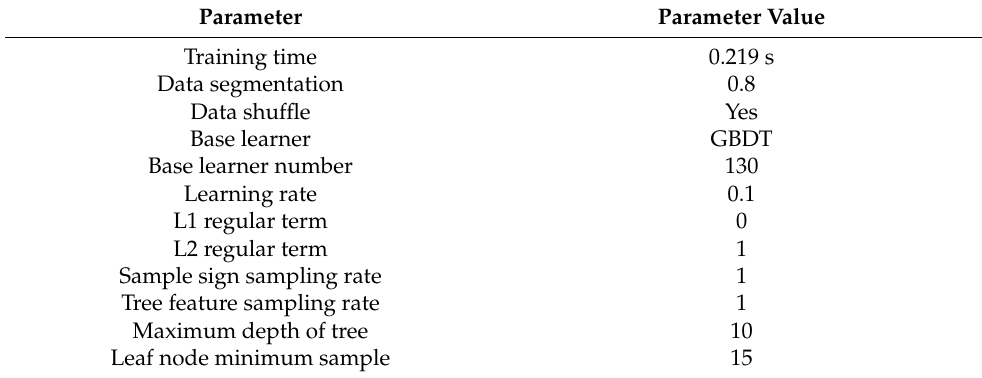
Table A2. The parameter values based on LightGBM machine learning